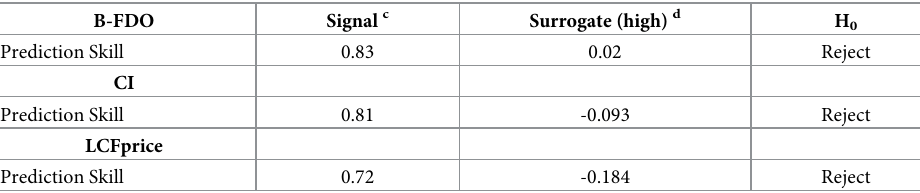
Table 2. Surrogate data results using rank-order statistics a,b